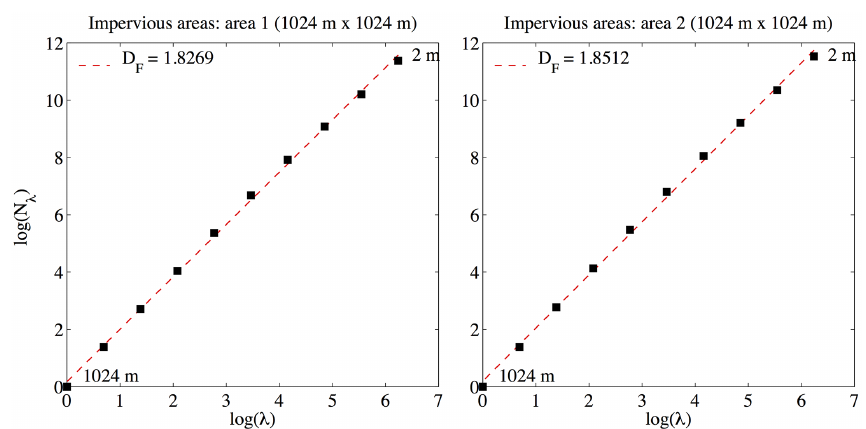
Figure 11. Fractal analysis of the impervious data. One unique scaling regime is identified across the whole range of available scales (2– 1024m); D f is greater than 1.8 for both